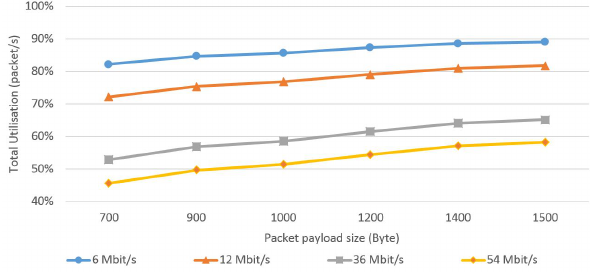
Figure 13: Channel utilisation rate for all pairs in Scenario 3.